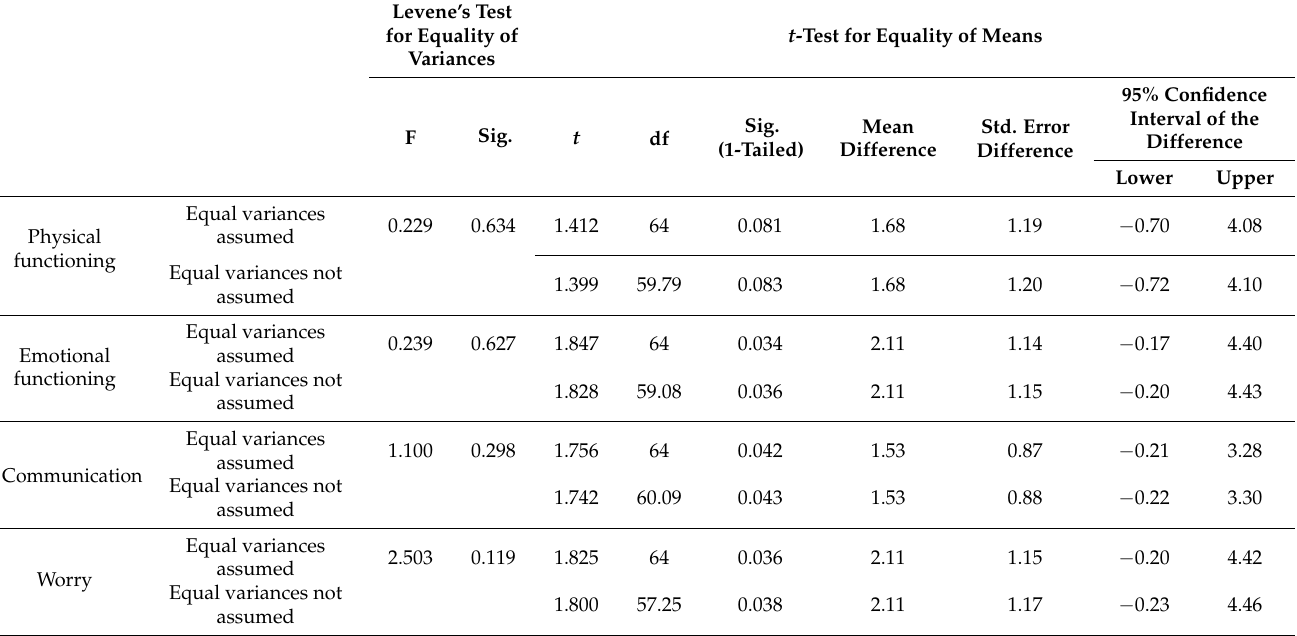
Table 3. Calculation of the p -value using the t -test for four PedsQL- FIM variables. Levene’s Test for Equality of